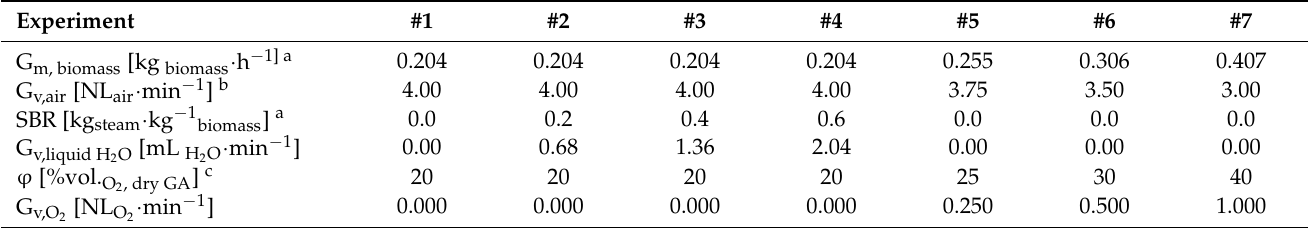
Table 3. Operating conditions of the experiments performed in this